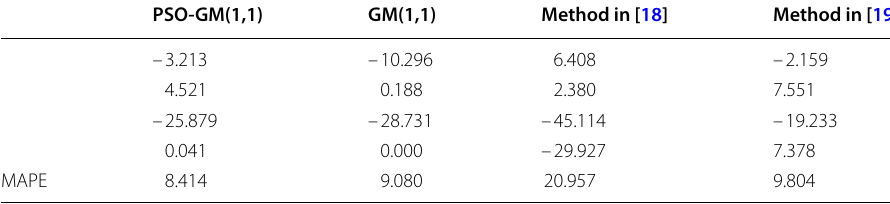
Table 5 Percentage forecast errors for energy data for a printer, associated with the various models